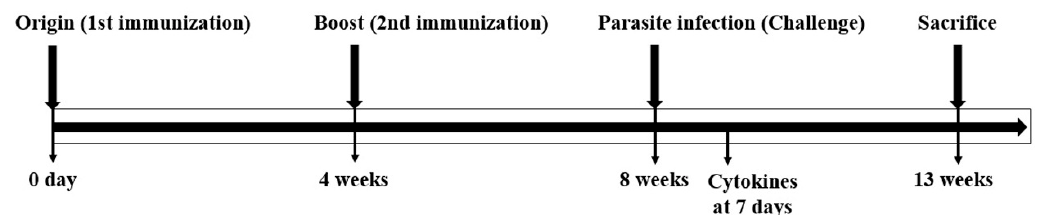
Figure 1. The experimental schedule for vaccination and Toxoplasma gondii infection. The mice were immunized twice with virus-like particles (VLPs) at origin (0 day) and boost (4 weeks), respectively. The parasite infection (challenge) was performed at 4 weeks after the second